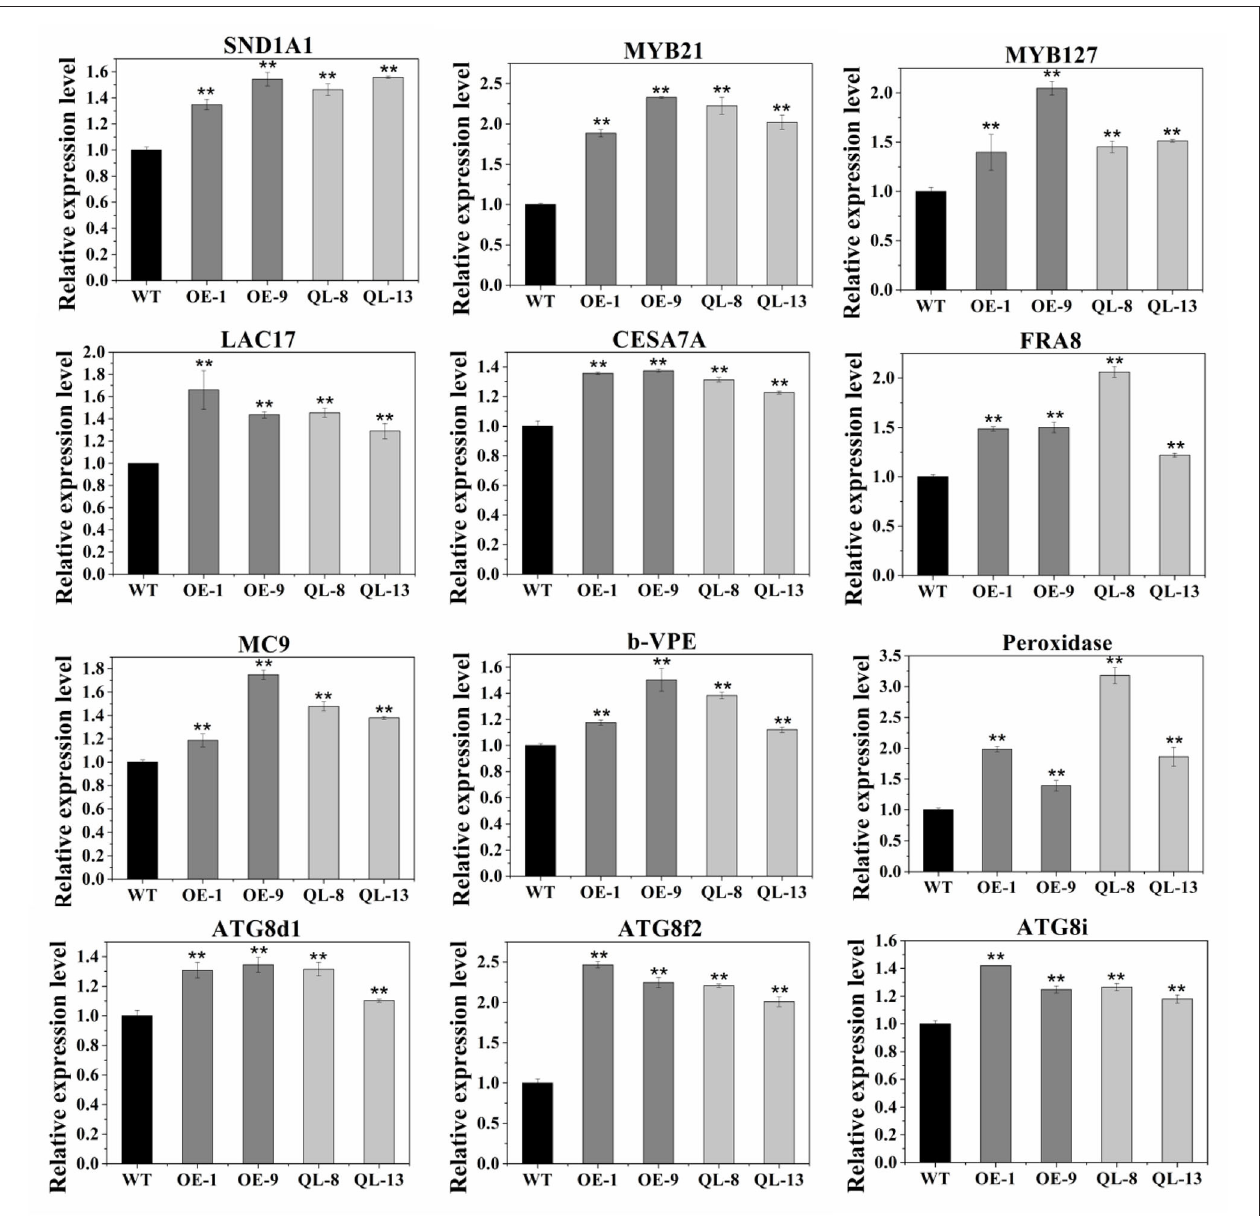
FIGURE 6 | Expression analysis of xylem development-related genes in WT, OE-1, OE-9, QL-8, and QL-13 lines. The poplar actin gene was used as an internal control. Results are means ± SD of three biological replicates. Student’s t -test; ** P <